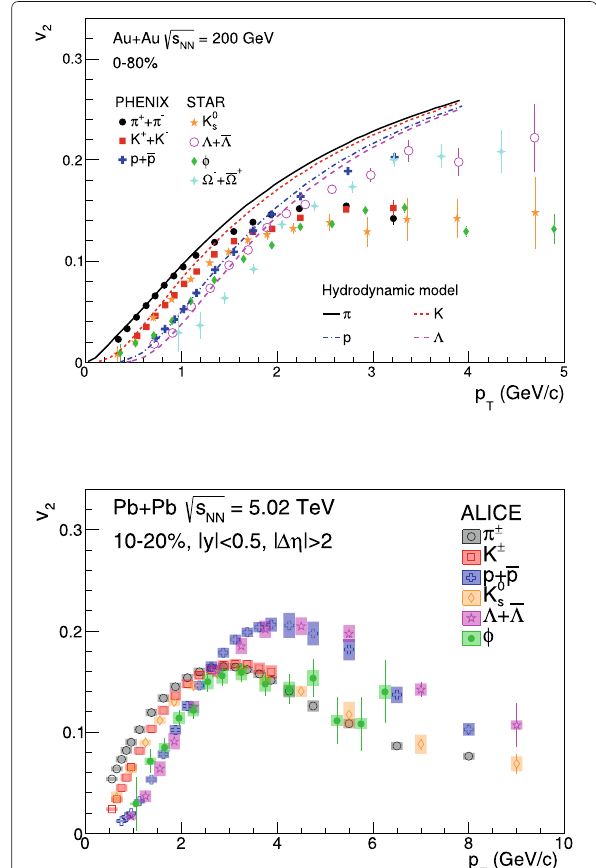
Fig. 6 (Upper panel) v 2 as a function of the transverse momentum for ( ¯ p ) , φ (cid:6)( ¯ (cid:6)) , and (cid:7) − ( ¯ (cid:7) + ) in Au+Au collisions at π ± , K ± , K 0 √ s , p s NN = 200 GeV from the STAR and PHENIX experiments [36–38]. Solid and dashed curves show the prediction of the hydrodynamic model [39]. (Lower panel) v 2 as a function of the transverse momentum for π ± , K ± , K 0 s , p ( ¯ p ) , φ , and (cid:6)( ¯ (cid:6)) in semi-central Pb+Pb √ s NN = 5.02 TeV from the ALICE experiment collisions at